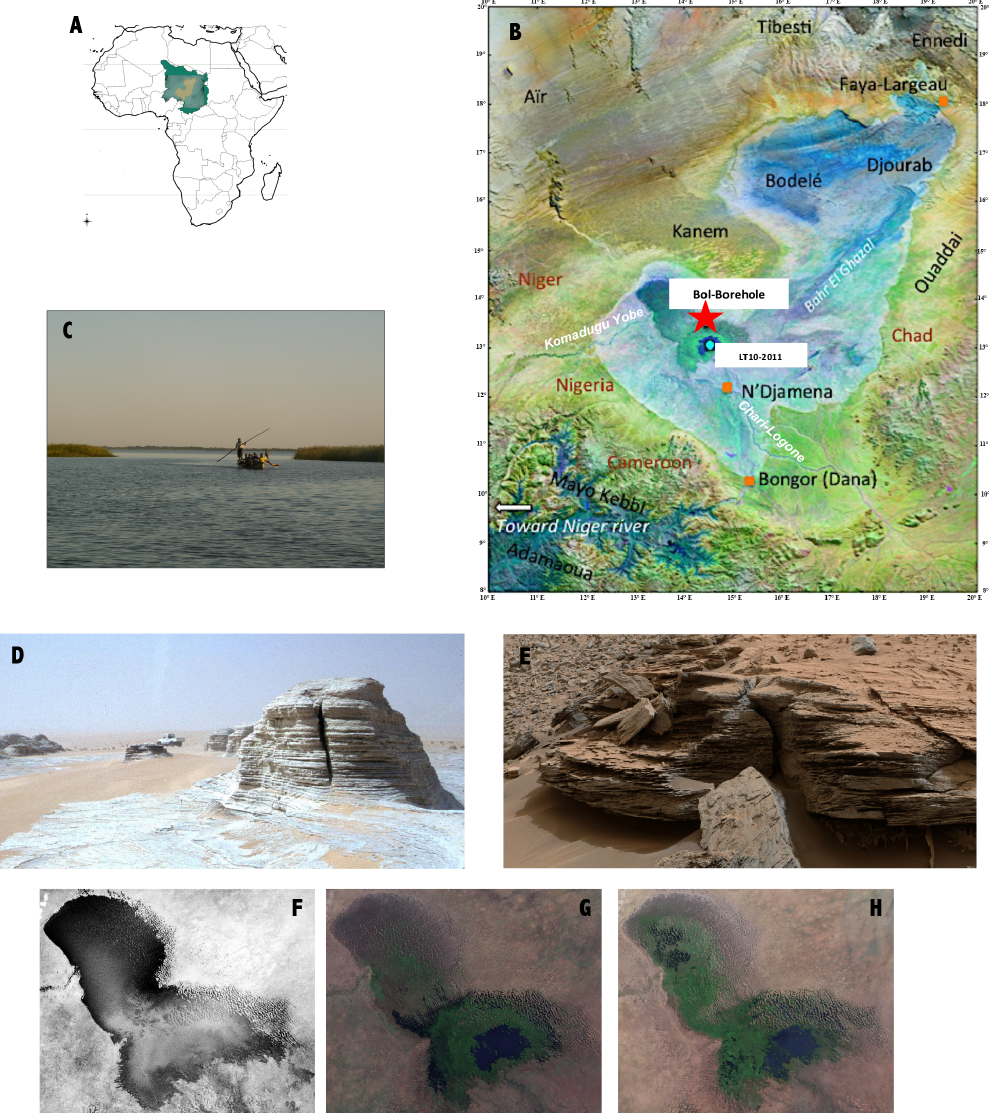
Figure 1. (a) Political map of Africa showing the Lake Chad hydrological basin. (b) SRTM map of the region surrounding Lake Chad. The shaded blue area marks the extension of the mega Lake Chad during the Holocene with an area of 34 × 10 4 km 2 . The principal populated towns are marked by red squares. The blue circle indicates the location of the previous core (LT10-2011) and the red star the borehole at Bol. (c) Picture of fishermen from Lake Chad. (d) Diatomite-dominated sequences deposited during previous transgressive episodes of Lake Chad currently outcropping in the Djourab region (see Fig. 1b for the location). The sediments date back to Holocene diatomites (Schuster et al., 2009). (e) Sediments of Mars (Rover pictures). Landsat images show the extension of the lake in 1963 (f) , 1987 (g) , and 2003 (h)